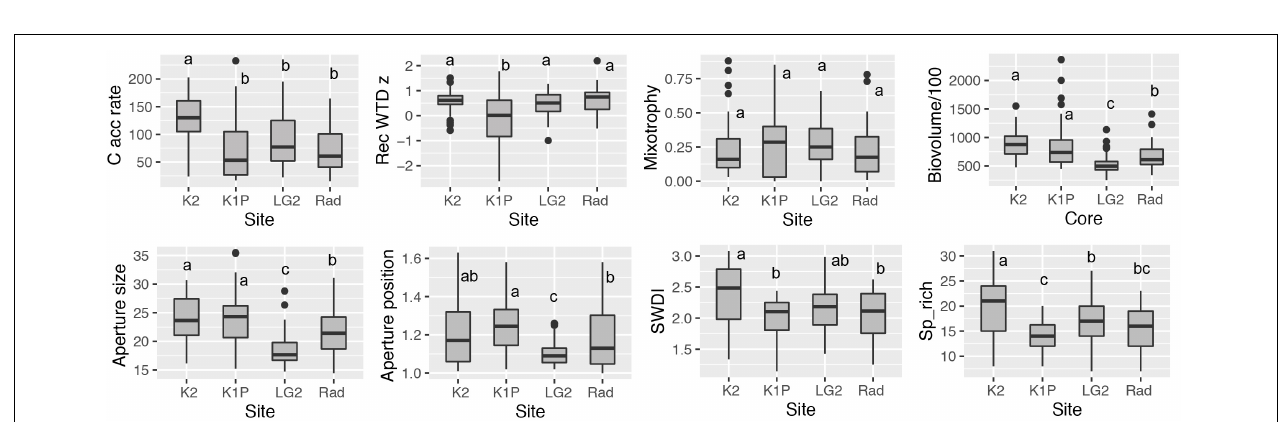
Frontiers in Ecology and Evolution |